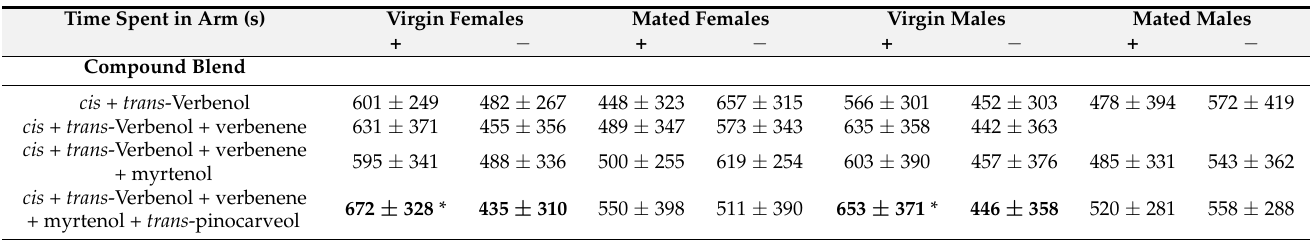
Table 2. Olfactometer responses of G. platensis to compound blends, expressed as the mean time ± SD spent in the treatment arm (+) vs. control ( − ) in seconds (Mann Whitney U tests, p < 0.05). Bold indicates that significant differences were observed between the time spent in the treatment and control arms. * Denote p <